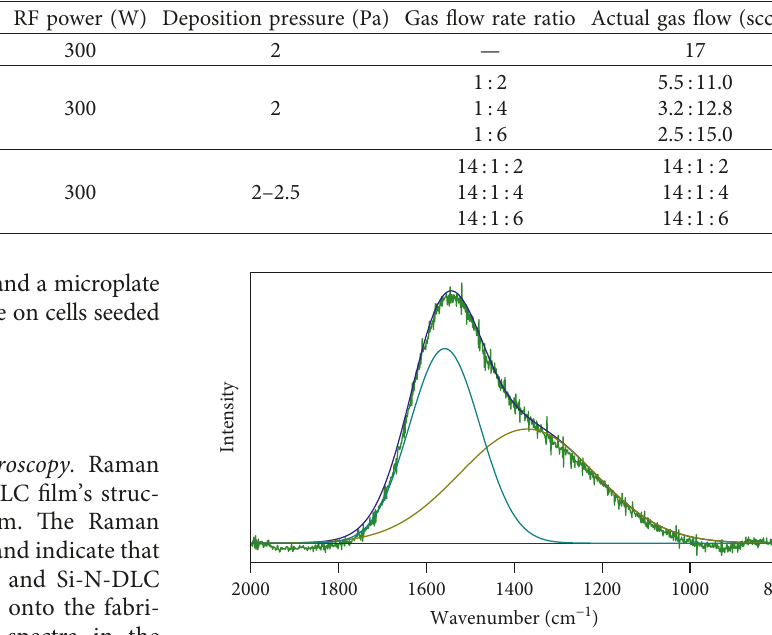
Table 1: Deposition of pure DLC, Si-DLC, and Si-N-DLC films.